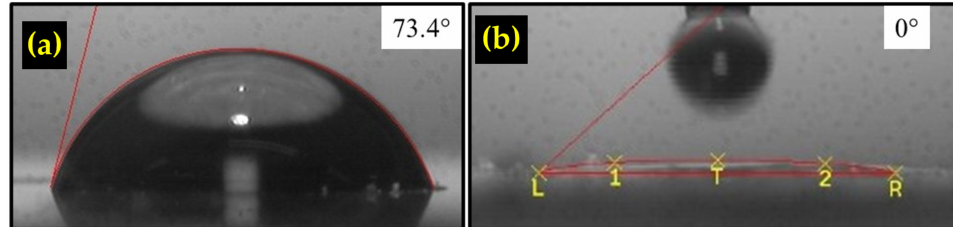
Figure 11. Contact angle measurement result of the ( a ) rGO thin film and ( b ) TiO 2 /rGO